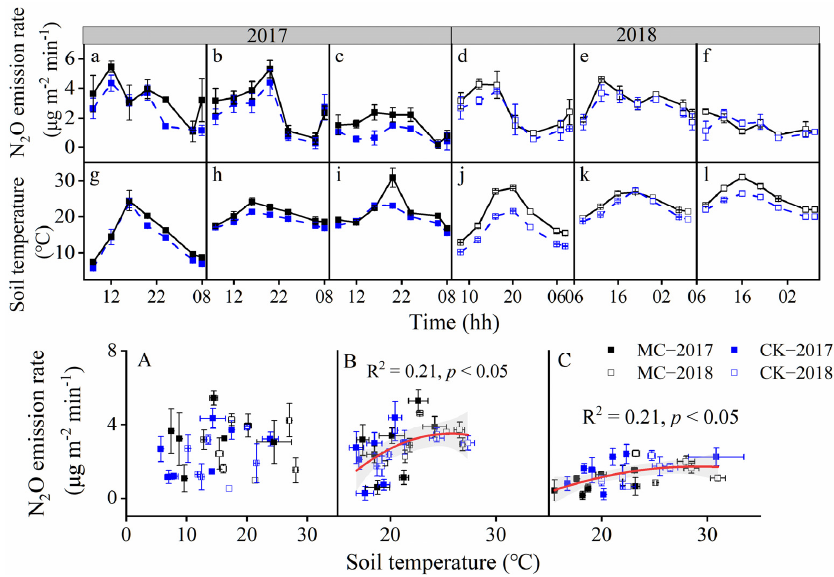
Figure 1. Diurnal variation of N 2 O emission rates and soil temperatures on three typical days at early ( a , d , g , j ), middle ( b , e , h , k ), and later ( c , f , i , l ) growth stage, and relationship between N 2 O emission rate with soil temperature at early ( A ), middle ( B ), and later ( C ) growth stage. The date of the three growth stages is introduced in supplementary methods. MC and CK are abbreviations for treatments with or without mulching, respectively. Vertical bars are the standard error of the mean ( n = 3).